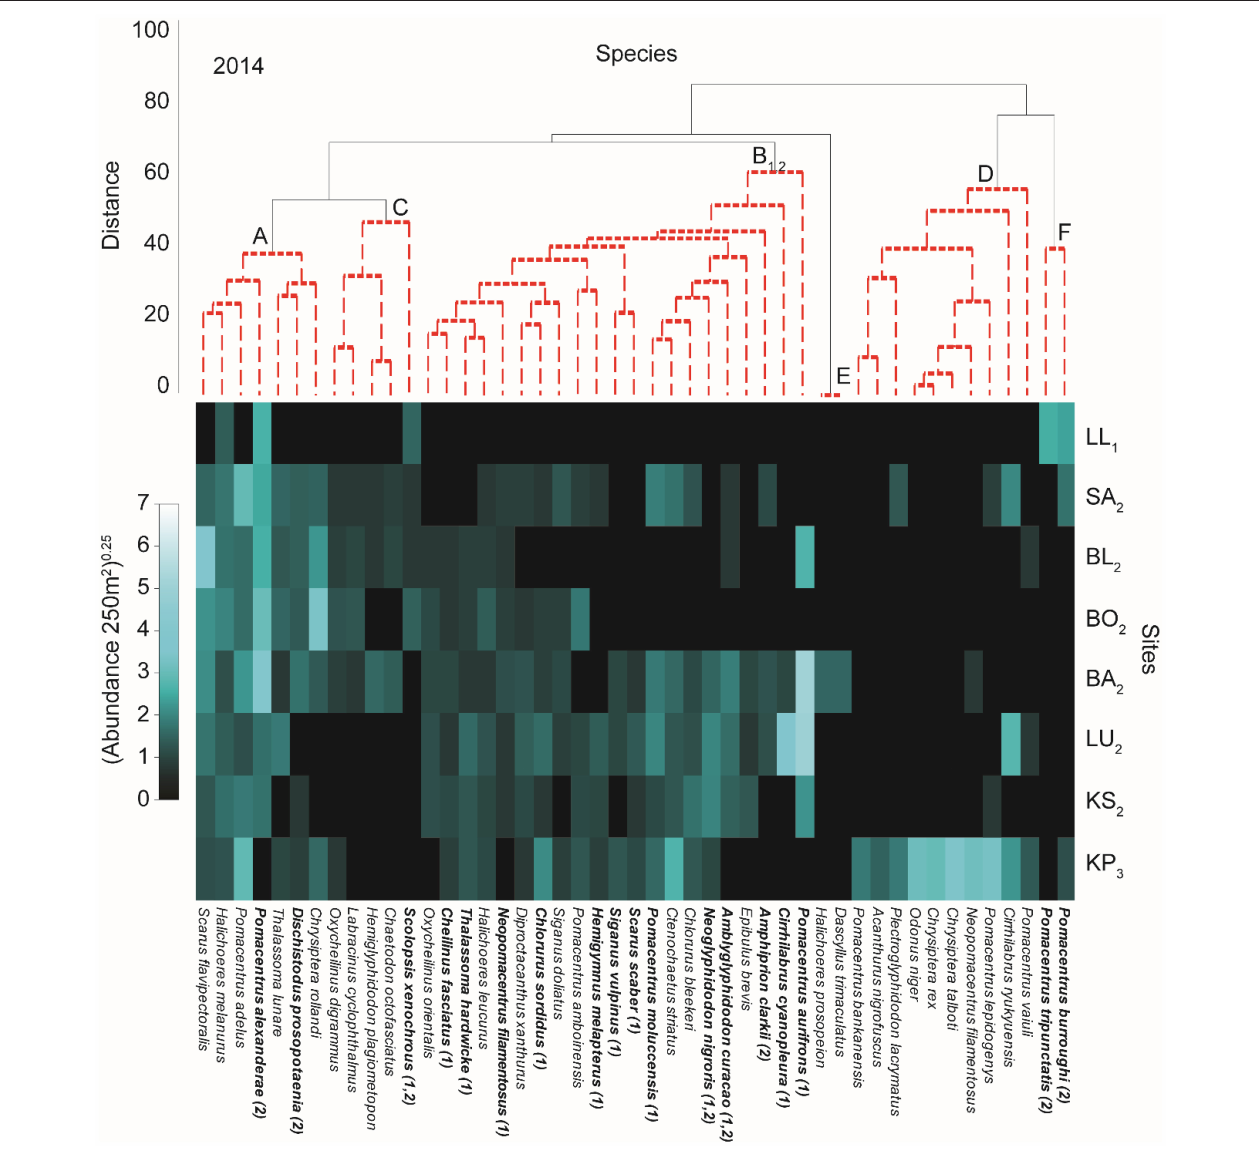
FIGURE 4 | Shade plot of relative species abundances in 2014. Results of cluster analysis showing significant groups (SIMPROF test) of species (capital lettering on species dendrogram and indicated with red dotted line) and sites (numbered subscript on site acronyms and identified in Supplementary Figure 1) with relative abundance of fish indicated in the shade plot. Sites are ordered from top to bottom increasing in distance from the mainland ( Figure 1 ). Subscript on species groups indicates a significant relationship with PCs of the benthic PCA (Supplementary Figure 3) as evaluated by multivariate GLM (Supplementary Table 2). Bolded species names indicate a specie that is related to at least one of the two (indicated in parentheses after specie name) benthic PCs. Full results for individual species can be found in Supplementary Table